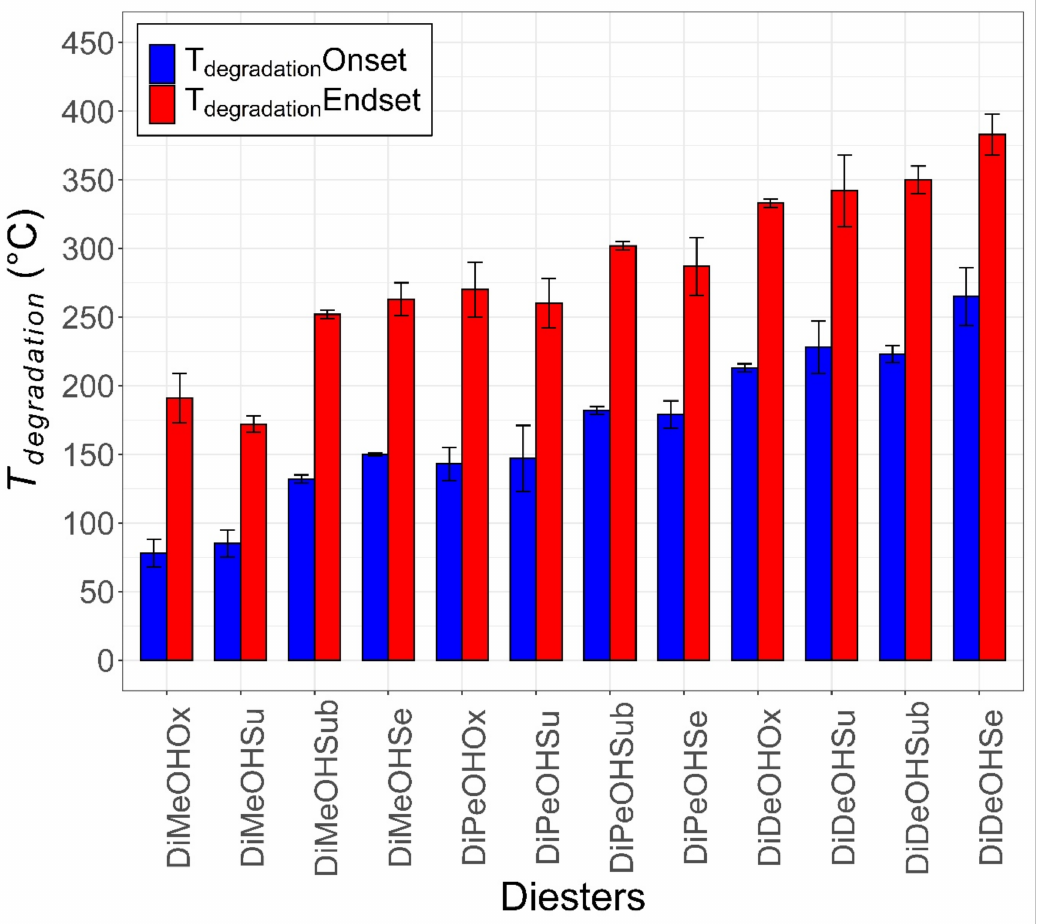
Figure 5. Bar plot showing the start (blue bar) and end (red bar) T degradation of the diesters presented. The onset T degradation is defined as the earliest temperature at which the diesters undergoes mass losses ≥ 5%, while the endset T ≥ 99%. The diesters degradation is the earliest temperature at which the mass loss are ordered according to increasing carbon number. A trend correlating the degradation temperatures to the carbon number can be seen, with the diesters with lower carbon numbers undergoing mass losses at lower